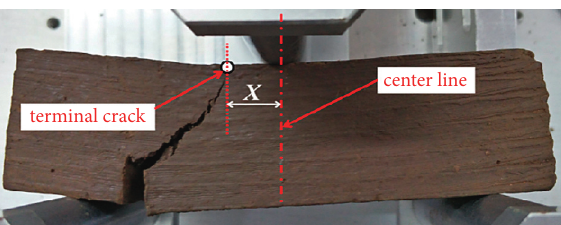
Figure 8: The distance from the terminal crack to the center line of the CCB with offset ratio C ≠